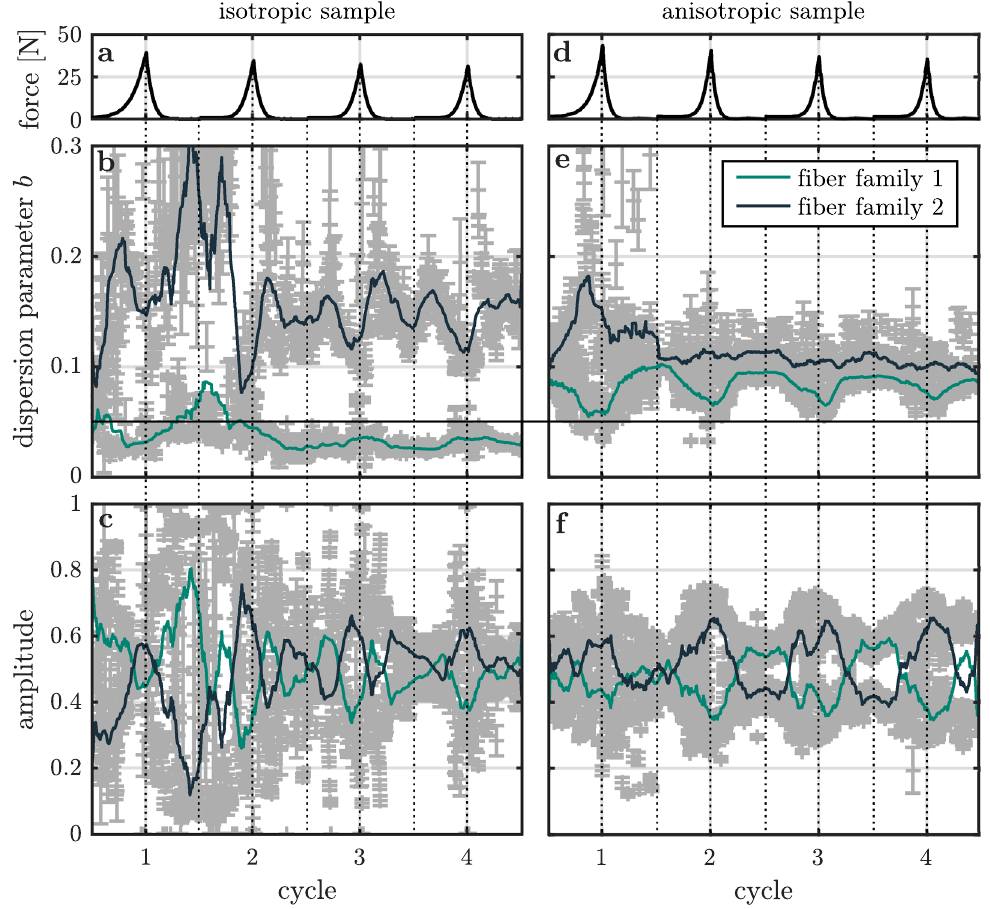
Figure 4. FINE algorithm parameters of the collagen fiber families of the isotropic and the anisotropic sample under repeated stretching and relaxation. ( a ) Averaged force acting on the isotropic sample, measured by the force sensors as a function of the deformation cycle number. ( b ) Dispersion parameter b of each fiber family identified by the FINE algorithm in the isotropic sample as a function of the deformation cycle number. Data points with error bars indicating the 95% confidence intervals are shown in grey. Solid lines represent smoothed data points. Note that, a third fiber family is identified in a negligible fraction of images ( ≤ 1% ). For the sake of clarity, parameters of this fiber family are not shown. The line at b = 0.05 indicates the threshold value below which a fiber family is considered as isotropic. ( c ) Amplitude of each fiber family identified by the FINE algorithm in the isotropic sample as a function of the deformation cycle number. ( d ) Averaged force acting on the anisotropic sample, measured by the force sensors as a function of the deformation cycle number. ( e ) Dispersion parameter b of each fiber family identified by the FINE algorithm in the anisotropic sample as a function of the deformation cycle number. ( f ) Amplitude of each fiber family identified by the FINE algorithm in the anisotropic sample as a function of the deformation cycle